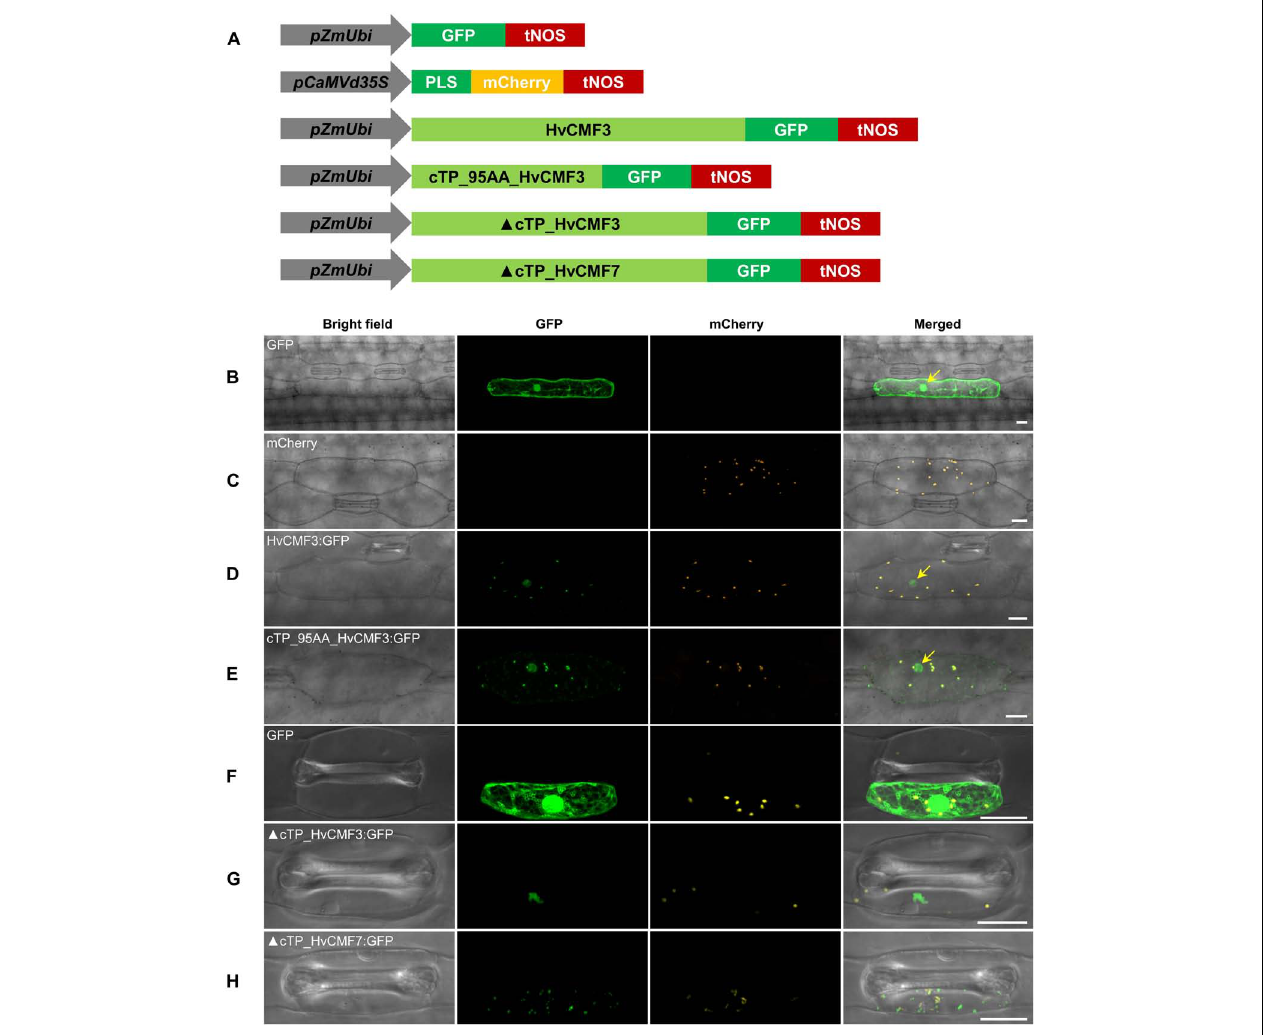
FIGURE 9 | Subcellular localization of HvCMF3. (A) Schematic diagram of the constructs prepared for transient expression. pZmUbi , maize UBIQUITIN1 promoter. pCaMVd35S , Cauliflower Mosaic Virus doubled-enhanced 35S promoter. GFP, green fluorescent protein. mCherry, mCherry fluorescent protein; PLS, plastid localization signal, i.e., the chloroplast transit peptide (N-terminal 79 amino acids) of the small subunit of tobacco RUBISCO. HvCMF3, coding sequence of wild type HvCMF3 gene. cTP_95AA_HvCMF3, N-terminal chloroplast transit peptide of HvCMF3 with a length of 95 amino acids as predicted by online tool PredSL. (cid:78) cTP_HvCMF3, HvCMF3 without N-terminal cTP (T2-T95). (cid:78) cTP_HvCMF7, HvCMF7 without N-terminal cTP (A2-A83). tNOS, Agrobacterium nopaline synthase terminator. The schematic drawing is not in proportion with gene length. The first leaf of 7-day-old barley seedlings was used for particle bombardment. The fluorescence was checked 24 h after bombardment. Scale bar for all images is 20 µ m. (B) Localization of GFP control with GFP being driven by the maize UBIQUITIN1 promoter. (C) Localization of the plastid marker. (D) Localization of HvCMF3:GFP. The GFP fluorescence signal is targeted both to plastid and nucleus. (E) Localization of cTP_95AA_HvCMF3:GFP. The yellow arrows in the merged panels indicate the nucleus. (F–H) Localization of GFP control (F) , (cid:78) cTP_HvCMF3 (G) , and (cid:78) cTP_HvCMF7 (H) . Both truncated HvCMF3 and HvCMF7 form aggregates in the cytoplasm.